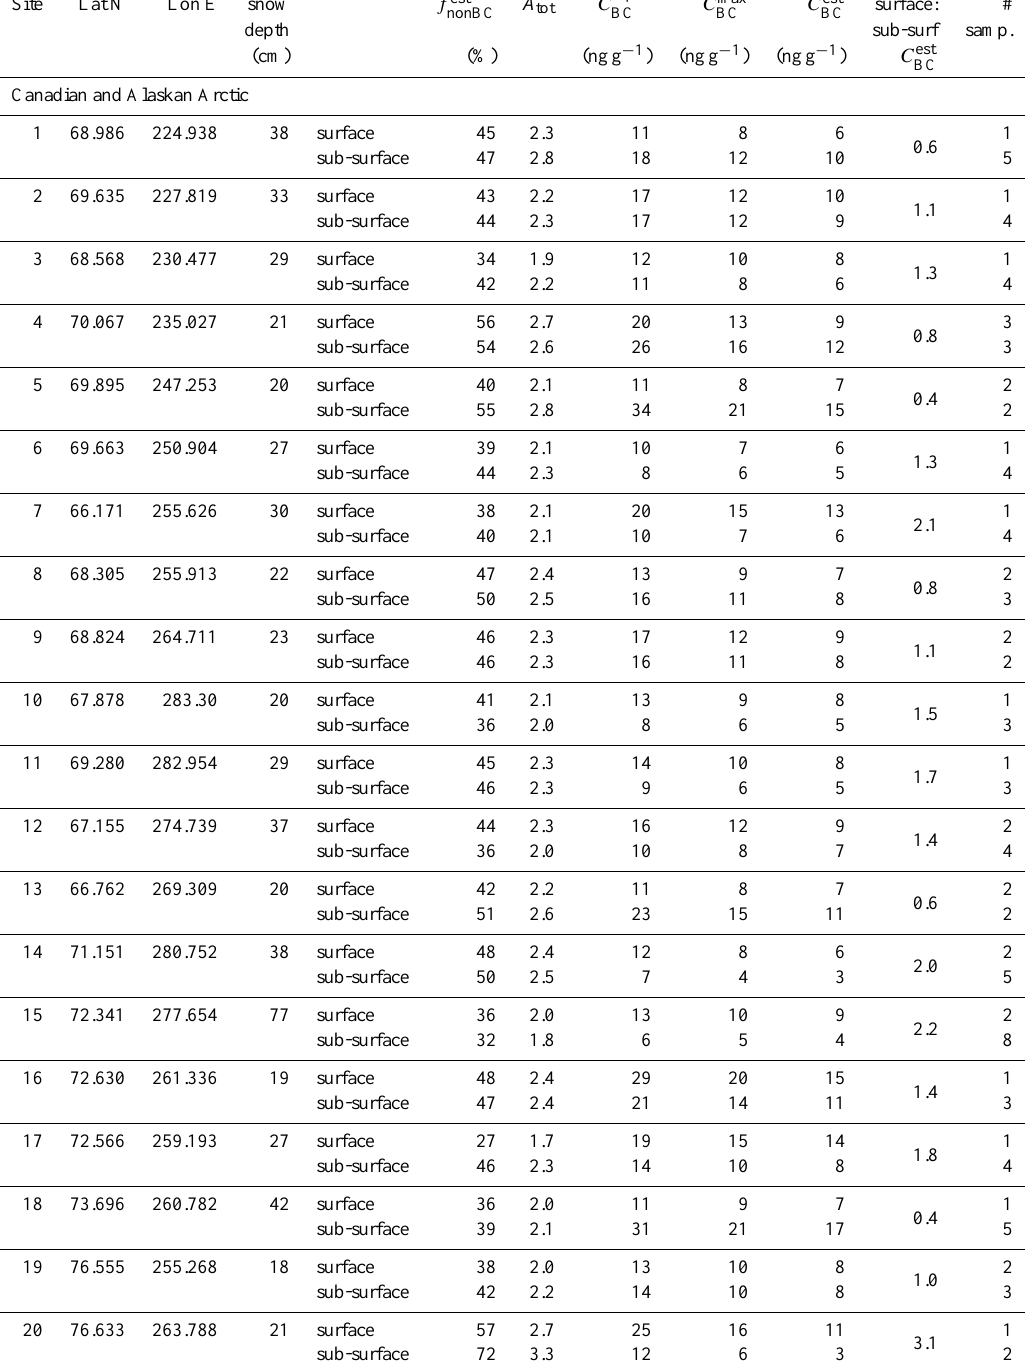
Table 5. Median values from the Canadian sub-Arctic (2007) and the Canadian (2009) and Alaskan (2007, 2008) Arctic. The 2009 sample sites are numbered, as given in Fig. 3; a 2007 sample from Eureka, Canada (EUR) and samples from Barrow (BRW) and McCall Glacier, Alaska (MCG) are included in the Arctic data set. For the sub-Arctic samples, surface samples are of the top 1cm of the snow, and the depth-integrated samples are of the top 20cm of the snow. For the Canadian Arctic, surface samples are typically from the top 1–3cm of the snow and the sub-surface samples from all depths below this, excluding the lowest sample in order to avoid contamination by surface soil or sea-ice algae. For the Arctic Canada sites 1–24, duplicate samples were taken at each level; the average of the pair is considered a single sample in this table. The sub-arctic samples are all from the snowmobile traverse of Sturm et al.